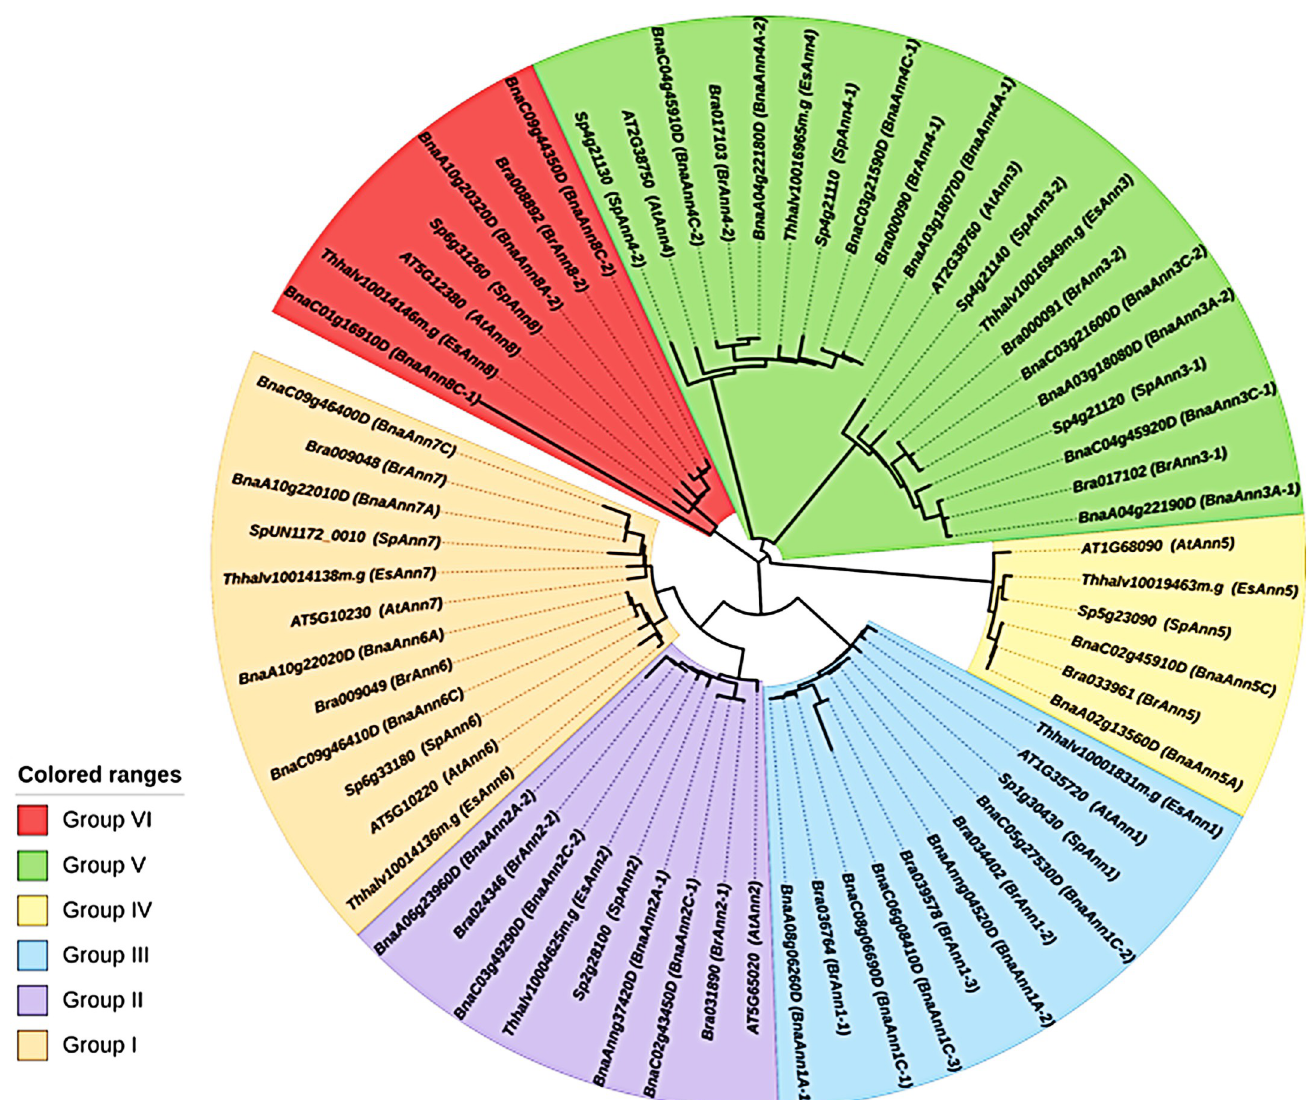
Fig 1. Phylogenetic analysis of SpAnn and EsAnn sequences. The six groupings are represented by the roman letters.